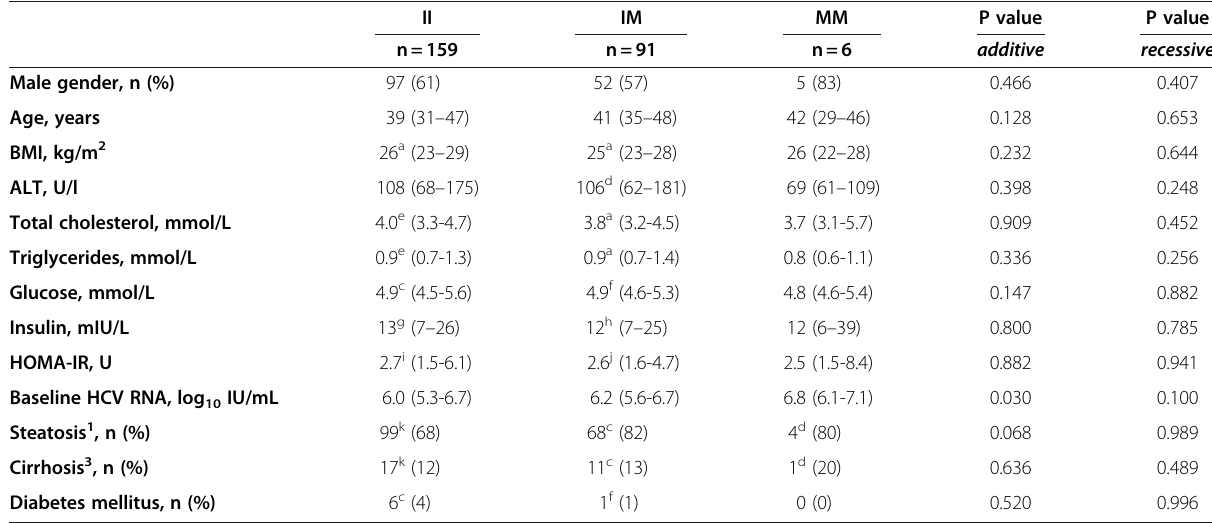
Table 3 Baseline characteristics according to PNPLA3 I148M sequence variant in HCV genotype 3 patients